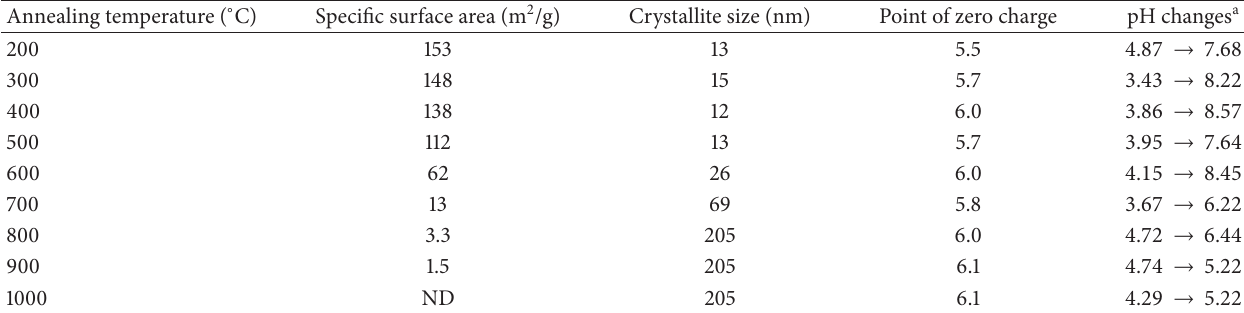
Figure 1: (a) SEM images of carbonate precursor dried at 110 ∘ C; (b) CeO 2 annealed at 500 ∘ C. Table 1: Properties of cerium oxide prepared by annealing at various